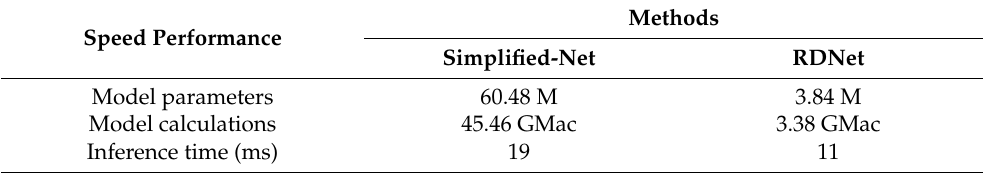
Table 7. Model parameters, calculations, and inference time of Simplified-Net and